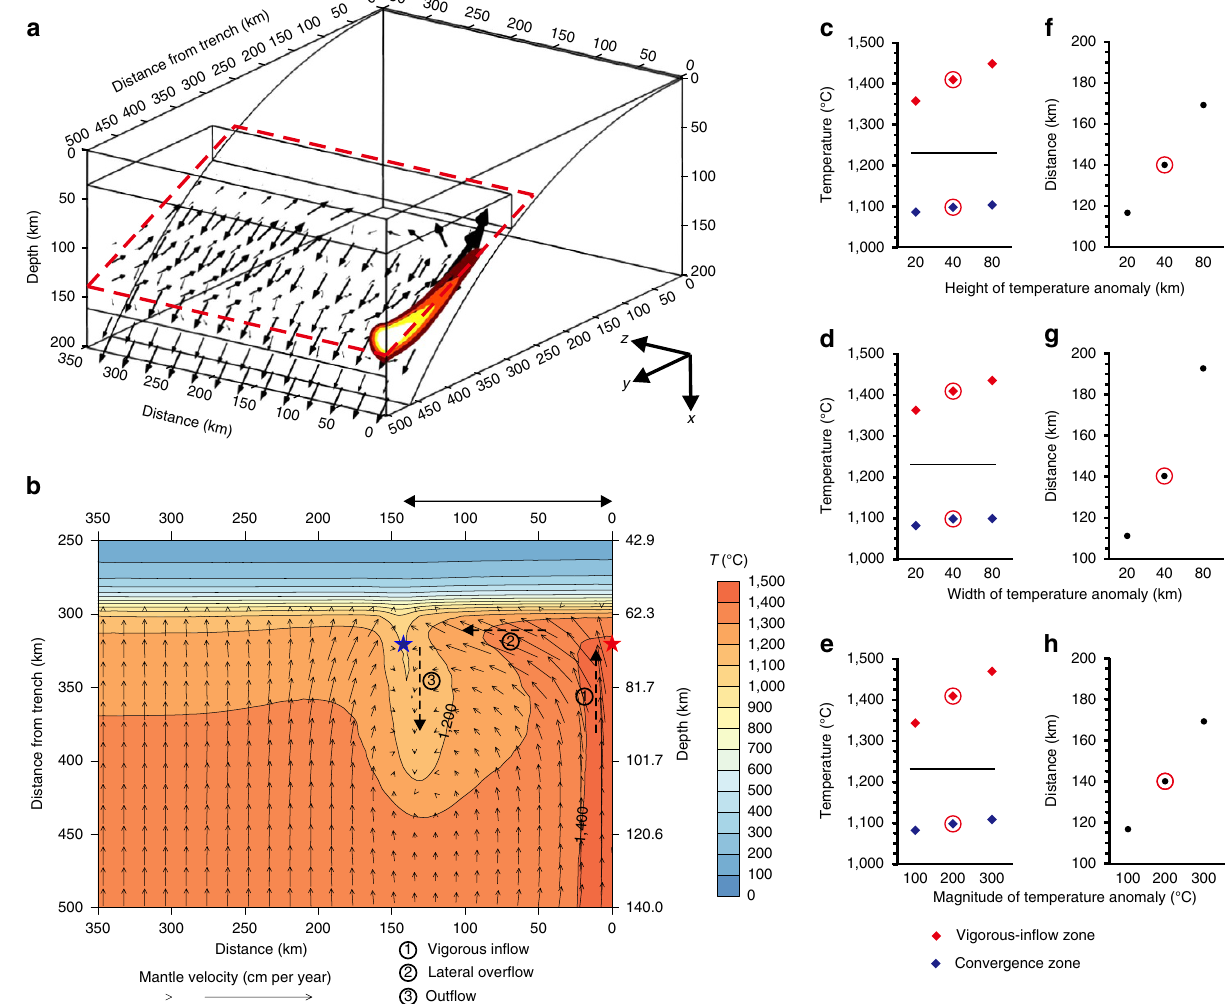
Figure 1 | Three-dimensional subduction model with a back-arc high-temperature anomaly. ( a ) Three-dimensional model geometry with one high- temperature anomaly (the reference model). Black arrows indicate the calculated mantle flow field. Colour indicates temperature in the vigorous inflow zone from 1,400 (cid:2) C (dark red) to 1,500 (cid:2) C (bright yellow). ( b ) Temperature distribution (colour) and mantle flow field (black vectors) on the dipping plane across the mantle wedge (indicated by the red dashed plane in a ) calculated from the reference model. The temperature contours are at every 100 (cid:2) C. The general three-dimensional flow pattern of mantle wedge can be described by combination of vigorous-inflow (1), lateral overflow (2) and outflow in the convergence zone (3). Red and blue stars at a distance of 320km from the trench indicate the probe locations for mantle temperature in the vigorous- inflow and convergence zones, respectively. ( c – e ) Variations in the sub-arc mantle temperature measured at the tip of the vigorous-inflow (red star in b ) and convergence zones (blue star in b ) with varying height, width and magnitude, respectively, of the high-temperature anomaly on the back-arc-side vertical boundary. Red circles indicate values from the reference model. Black line indicates the mantle temperature from the model without the high- temperature anomaly. ( f – h ) Distance between the vigorous-inflow (red star in b ) and convergence zones (blue star in b ) with varying height, width, and magnitude, respectively, of the high-temperature anomaly on the back-arc-side vertical boundary. Red circles indicate values from the reference